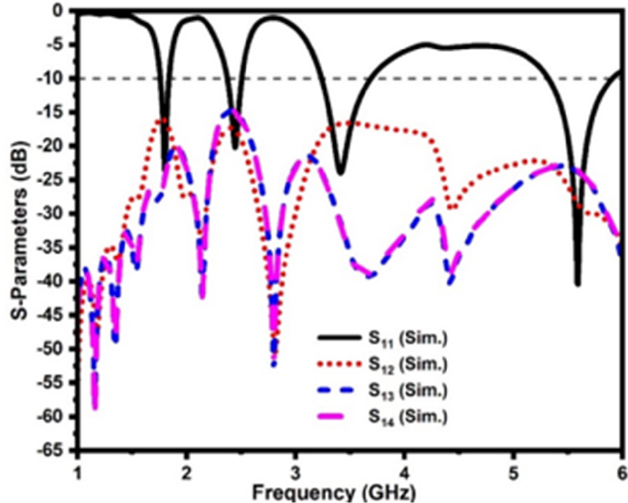
Figure 6. Simulated S − parameters of the proposed DS MIMO antenna.